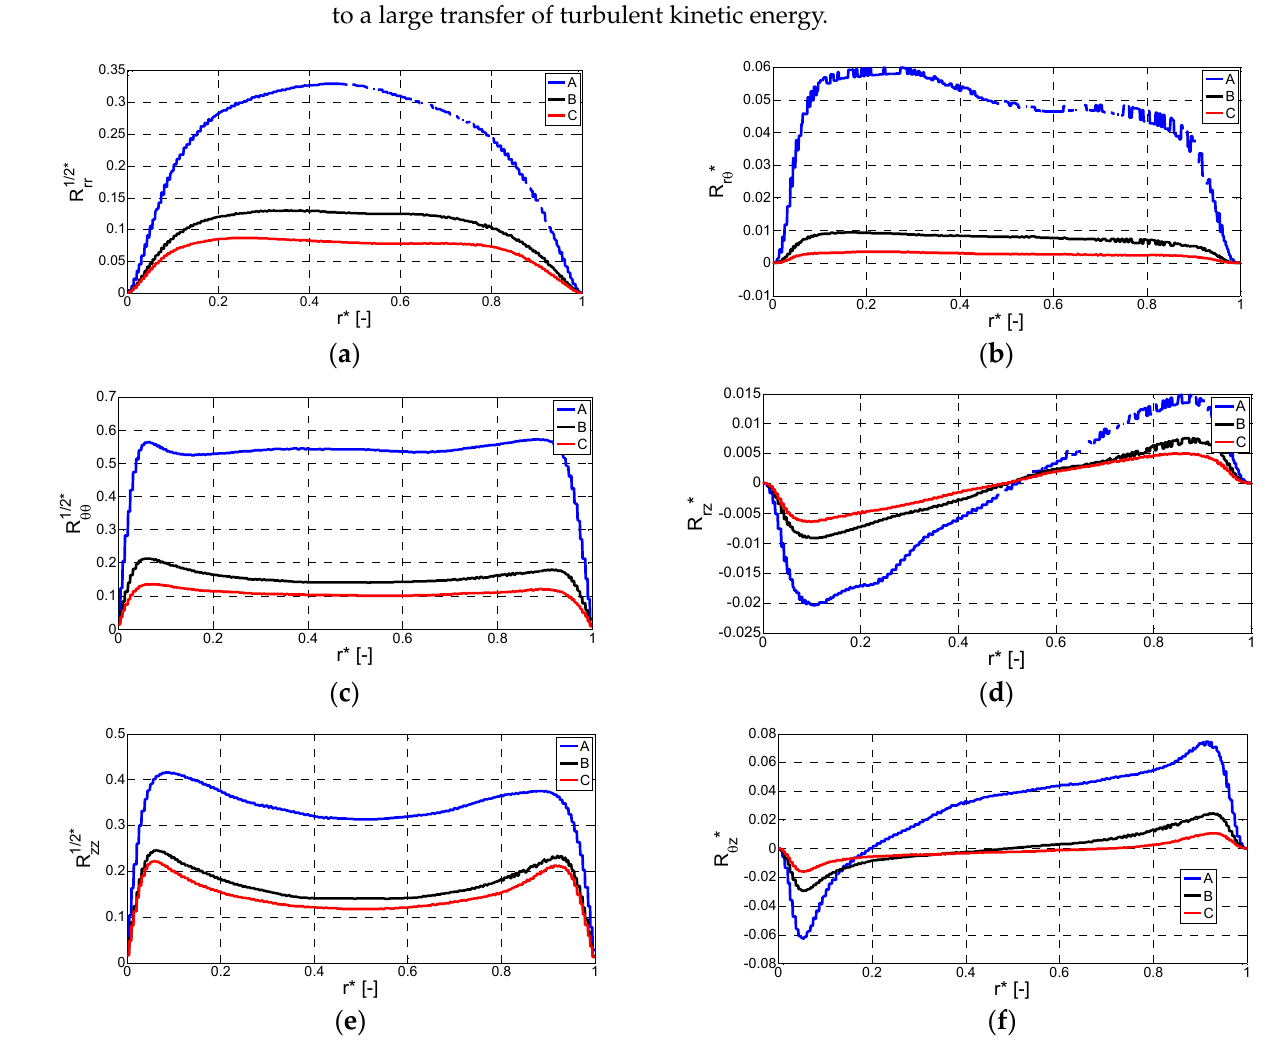
Figure 11. Radial distribution of the energy redistribution parameter obtained by the LES OneEqEddy model of OpenFOAM. The parameter (cid:1837) ∗ is greater than 1 for N C = 0.85 and N B = 1.71, and close to 1 for N A = 5.12. Therefore, the contribution of the axial turbulence intensity of the turbulent kinetic energy (cid:1873)′ (cid:3053)(cid:2870) (cid:3364)(cid:3364)(cid:3364)(cid:3364) is larger than the contribution of the other two normal components of the flow. With the increase in the rotational speed contribution, the values of (cid:1837) ∗ decrease and are significantly lower than the values obtained by Chung et al., (2002) [26] in stationary cyl ‐ inders. This decrease in the values of (cid:1837) ∗ can be explained by the increase in the contribu ‐ tion of the turbulent intensity (cid:1873)′ (cid:3087)(cid:2870) (cid:3364)(cid:3364)(cid:3364)(cid:3364) on the flow with rotation. As expected, the contribu ‐ tions of (cid:1873)′ (cid:3053)(cid:2870) (cid:3364)(cid:3364)(cid:3364)(cid:3364) decrease strongly with increases in the parameter N. For large values of N, the rotational effect dominates over the axial flow. 4.3. Boundary Layer Properties